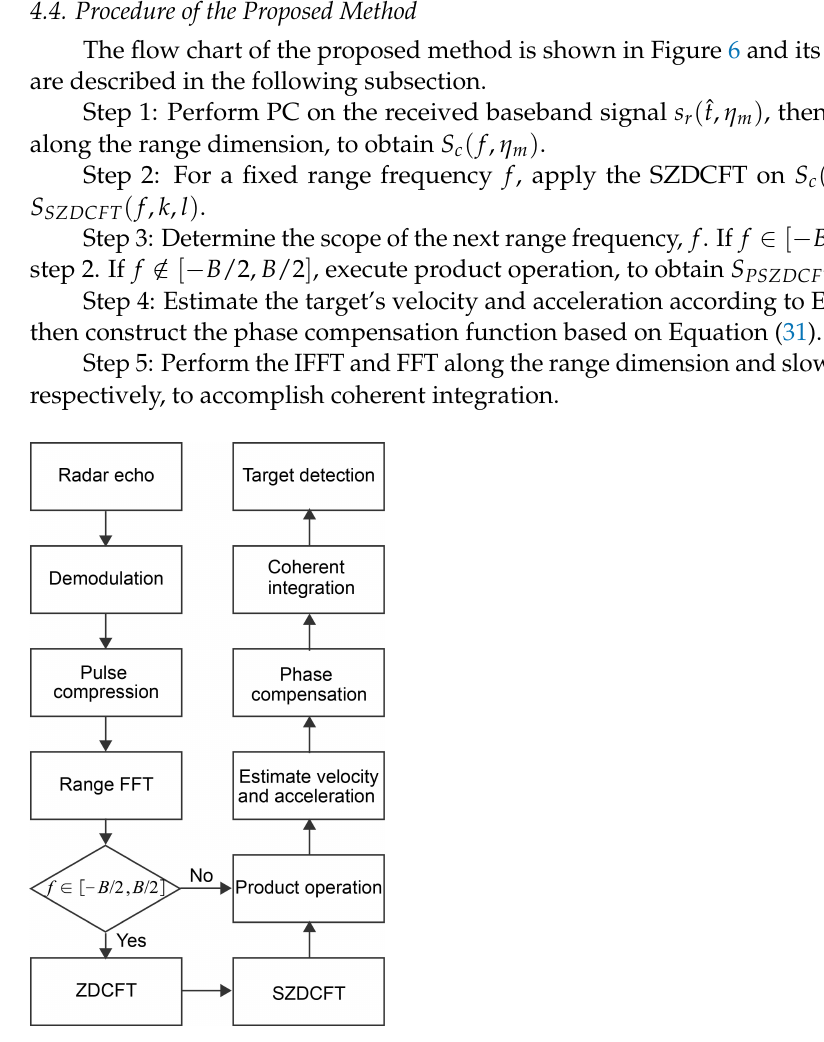
Figure 6. The flowchart of the proposed